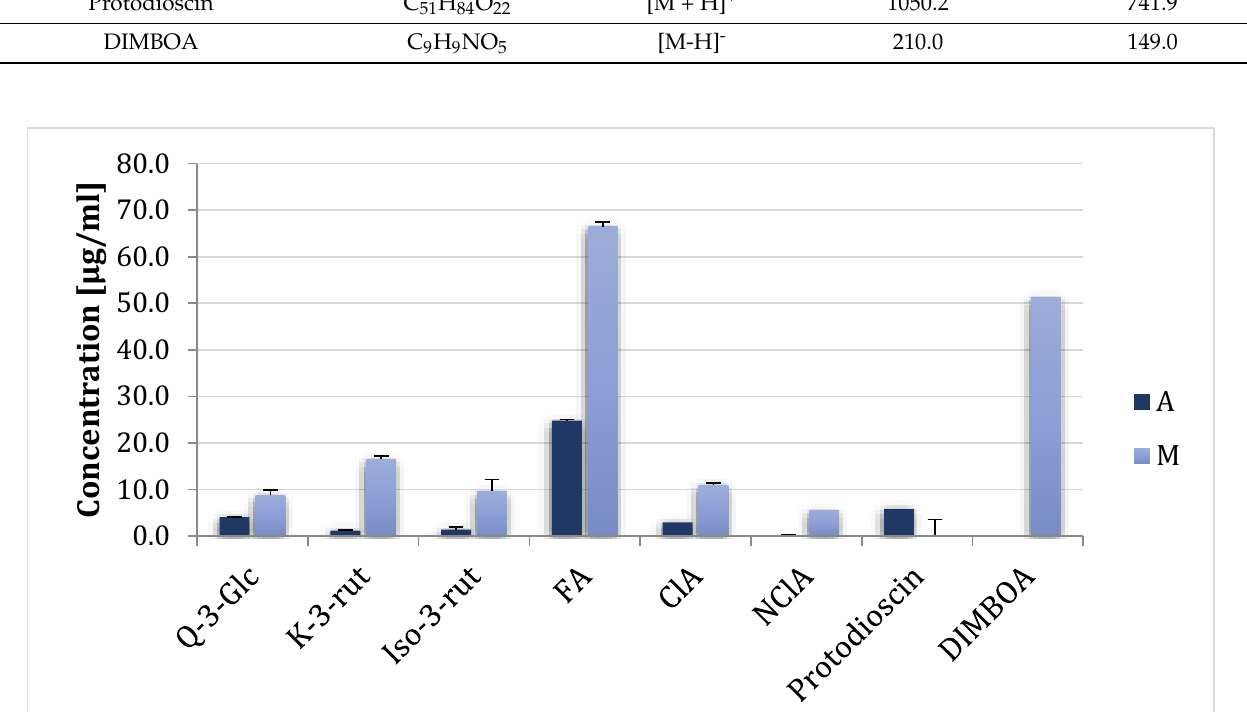
Figure 1. Concentrations of plant metabolites used in the study in water extracts from asparagus spears and maize ears. A—asparagus, M—maize. Values are means of three repetitions ± standard deviation.